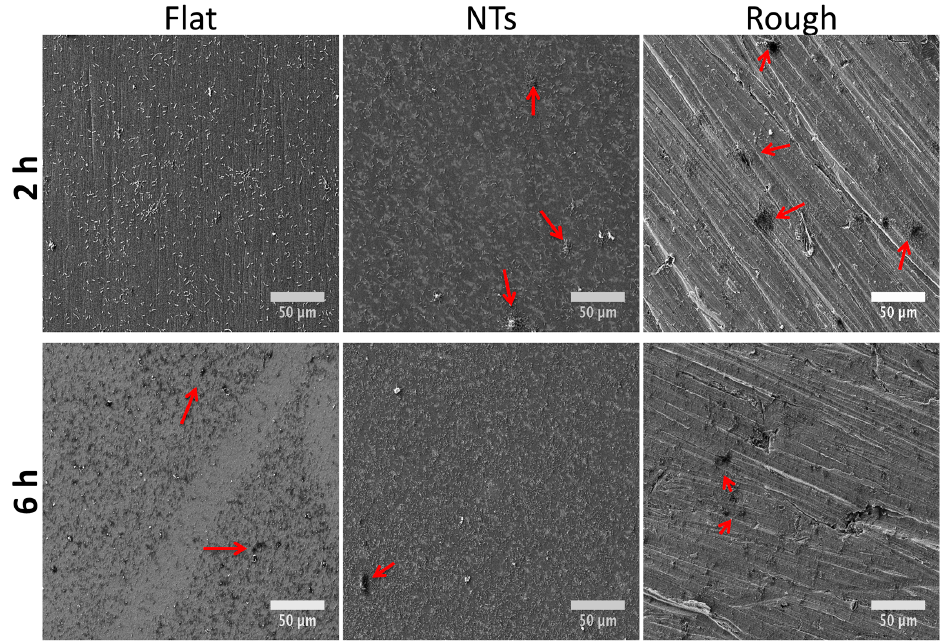
Figure 6. P. aeruginosa colonization over the materials at 2 and 6 h of growth. Red arrows symbolize the initial formation of bacterial colonies.